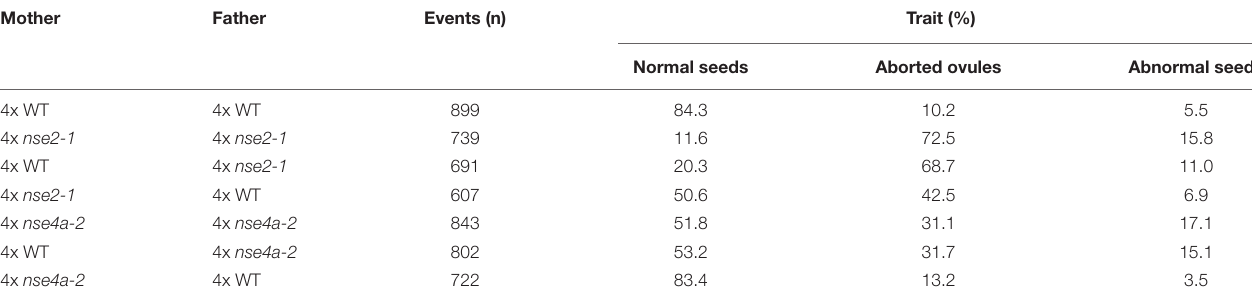
TABLE 1 | Seed phenotype of self-pollinated and reciprocally crossed between tetraploid (4x) WT, nse2-1 , and nse4a-2 plants. Mother Father Events (n) Trait (%) Normal seeds Aborted ovules